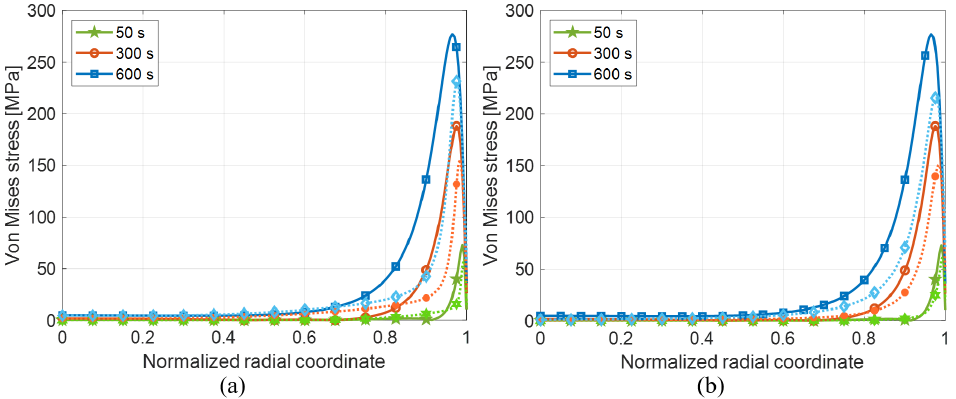
Figure 8. Von Mises stress in contact domain at increasing simulation times. Von Mises stress of coupled and uncoupled model in solid and dashed lines, respectively ( a ). Von Mises stress of the complete model (diffusion and contact) and contact alone in solid and dashed lines, respectively ( b ). Lithium flux 1 A/m 2